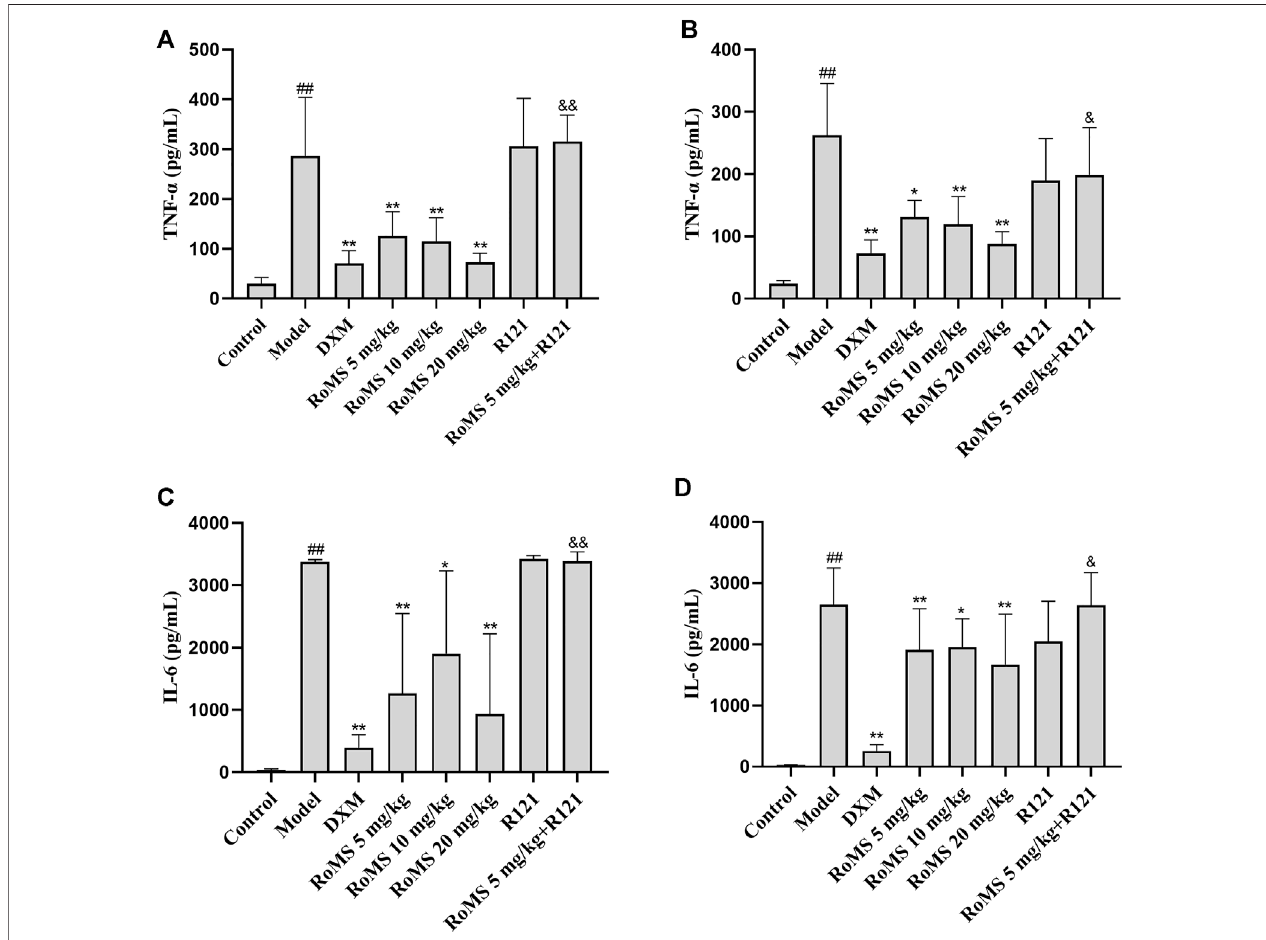
FIGURE5| Effect ofRoMS on thelevels ofTNF- α and IL-6 insepticmice.At3days after RoMS pre-administration (A,C) . At7 days after RoMS pre-administration (B,D) .TheDataareexpressed asthemean±SD(n=8ineach group). ## p < 0.01versusthecontrolgroup,* p < 0.05or** p < 0.01versusthemodelgroup, & p < 0.05or && p < 0.01 versus RoMS 5 mg/kg